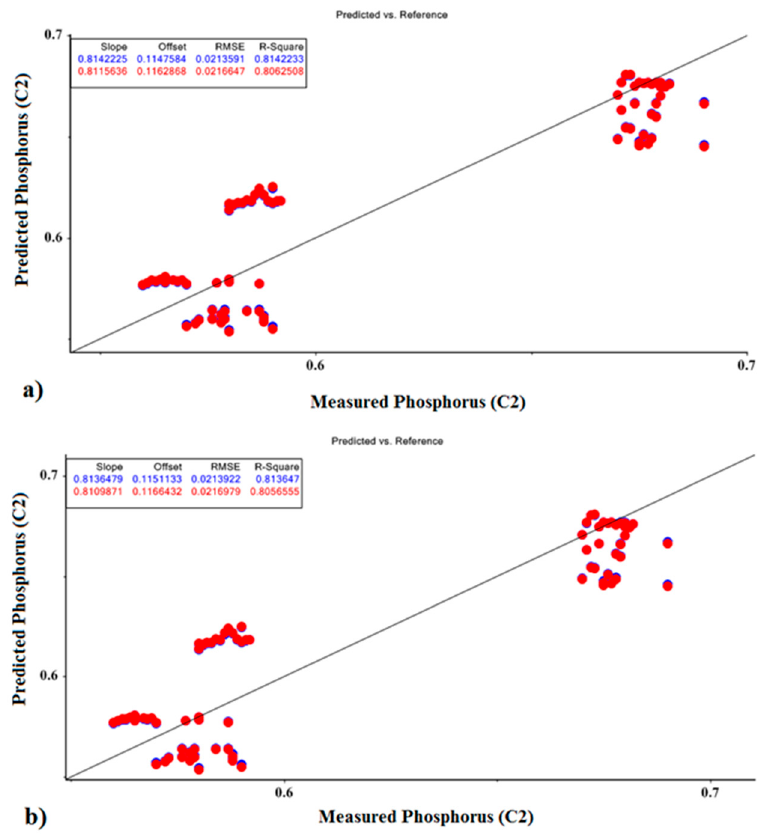
Figure 9. MLR prediction models for phosphorus fertilizer based on optimal factors of ( a ) PCR model and ( b ) PLSR model.